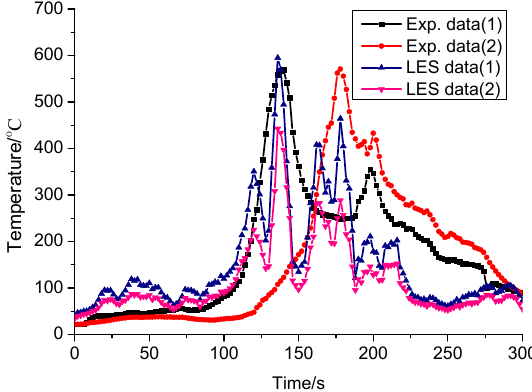
Figure 7. Surface temperatures in the experiment and LES simulation.